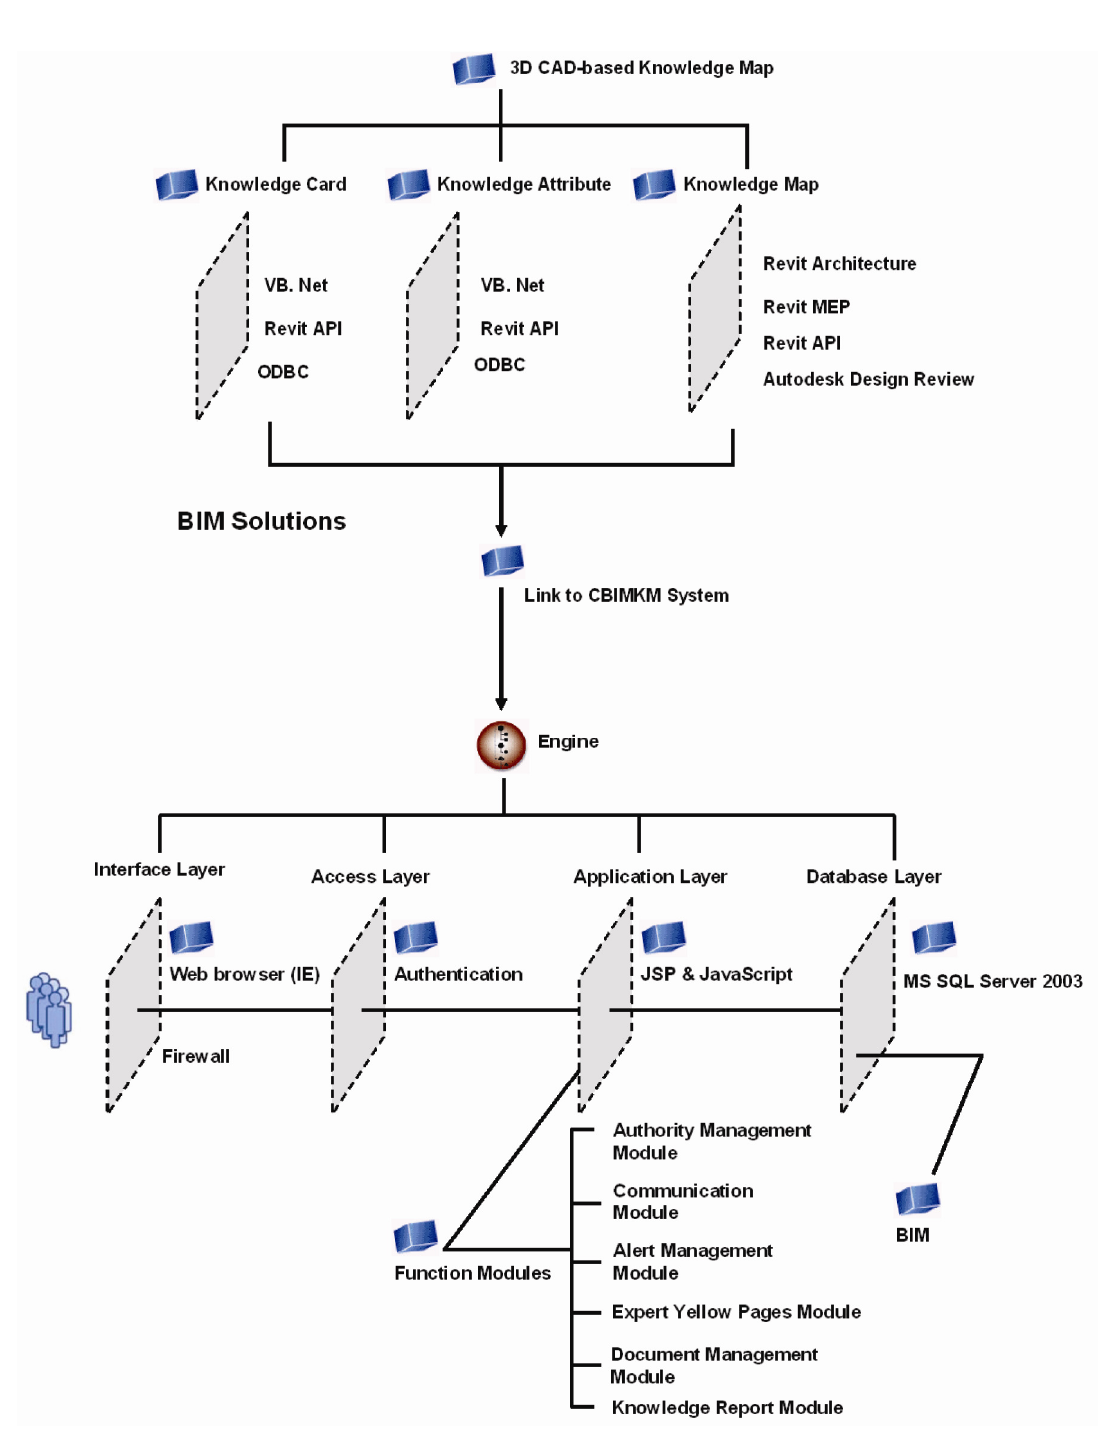
Fig. 4. System concept and